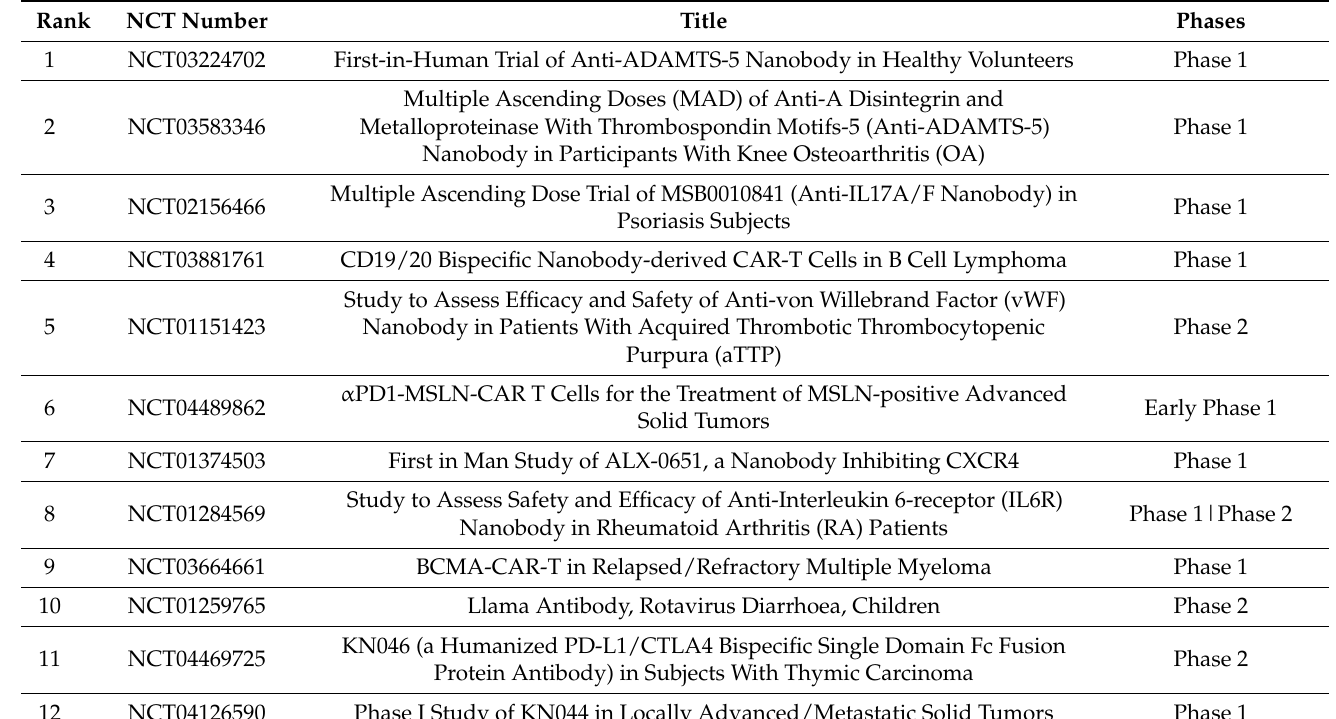
Table 2. Study progress for nanobodies or single-domain antibodies in preclinical and clinical trials (data sources for clinical trials: https://clinicaltrials.gov/, accessed on 9 August